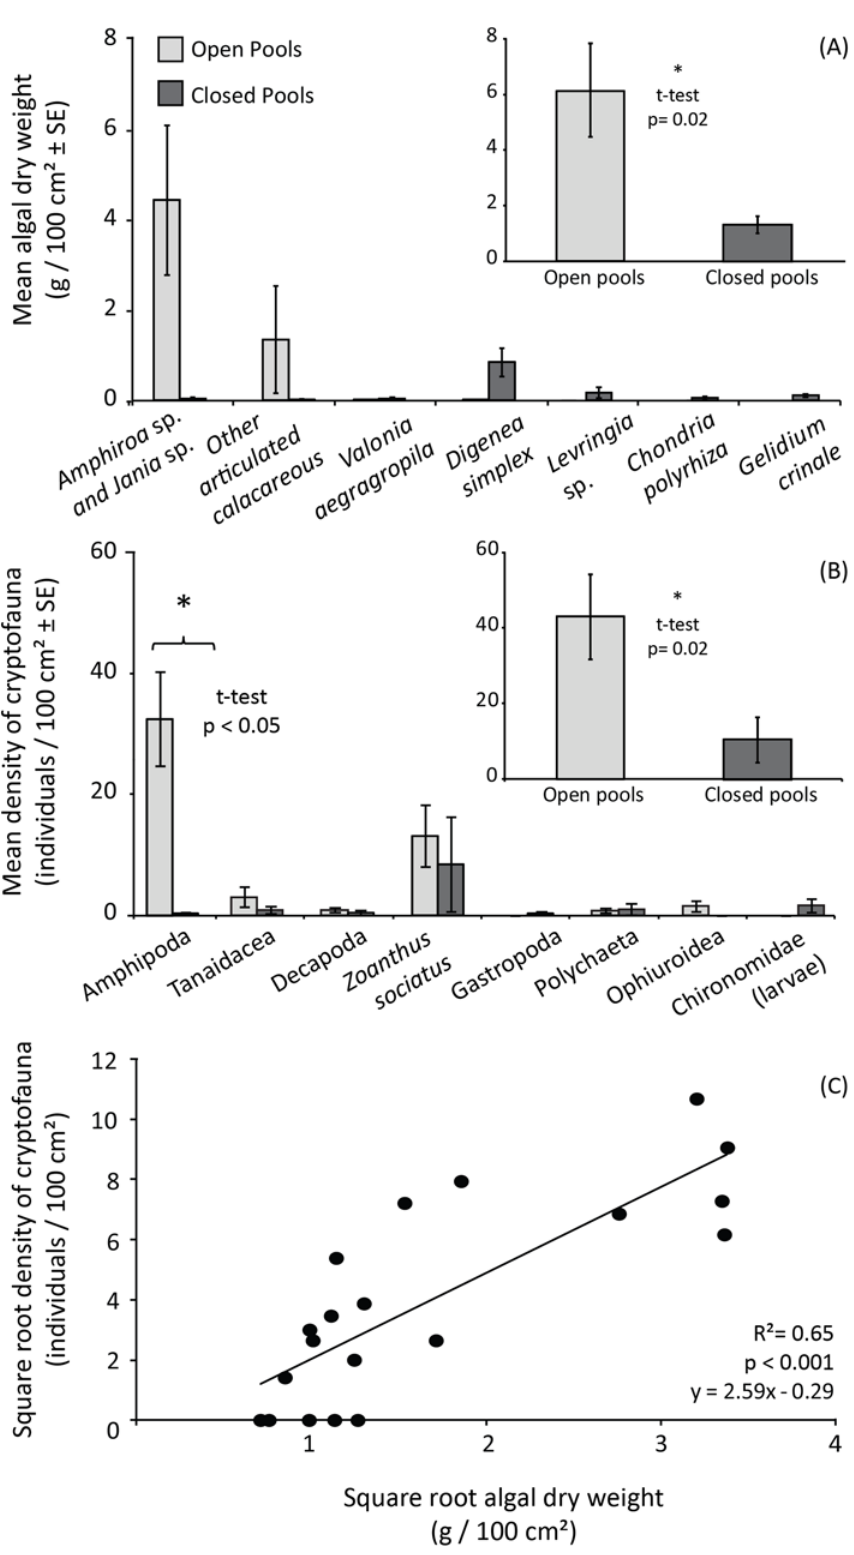
Fig 6. Algal turf species composition and density of associated cryptofauna in open and closed pools. (A) Mean biomass of the main turf-forming macroalgae; (B) mean density of cryptofauna associated to